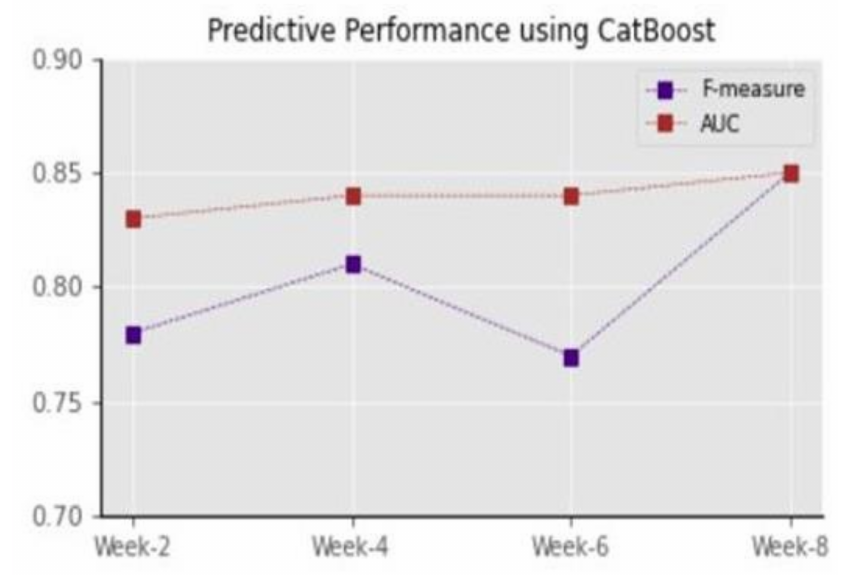
Figure 2. F-measure and AUC plot of CatBoost on the Computer Applications and the Information Age—Semester 03 hold-out